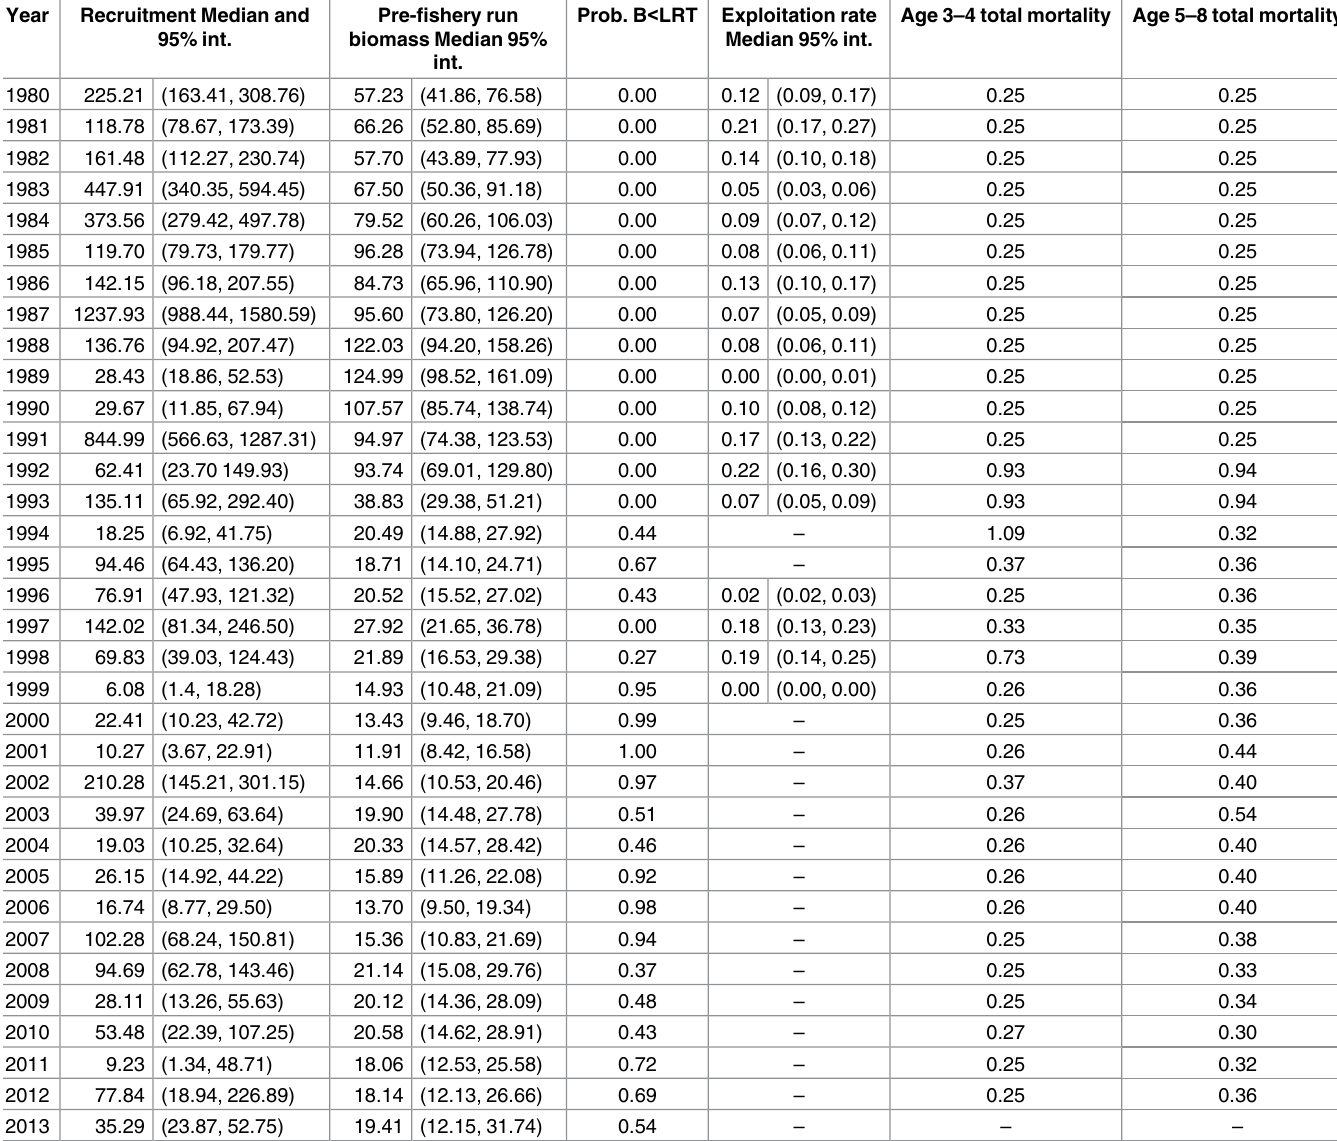
Table 4. Recruitment (median and 95% credible intervals) in millions of age-3 fish, pre-fishery run biomass (median and 95% interval) in 10 3 mt, the probability that pre-fishery run biomass has fallen below the lower regulatory threshold (B < LRT), exploitation rate (median and 95% interval) defined as total catch in each year (converted to metric tons using the empirical weight-at-age matrix) divided by the 95% biomass trajectories(3 rd column), total instantaneous mortality for age 3–4 fish, and total instantaneous mortality for age 5–8 fish. Year Recruitment Median and 95%